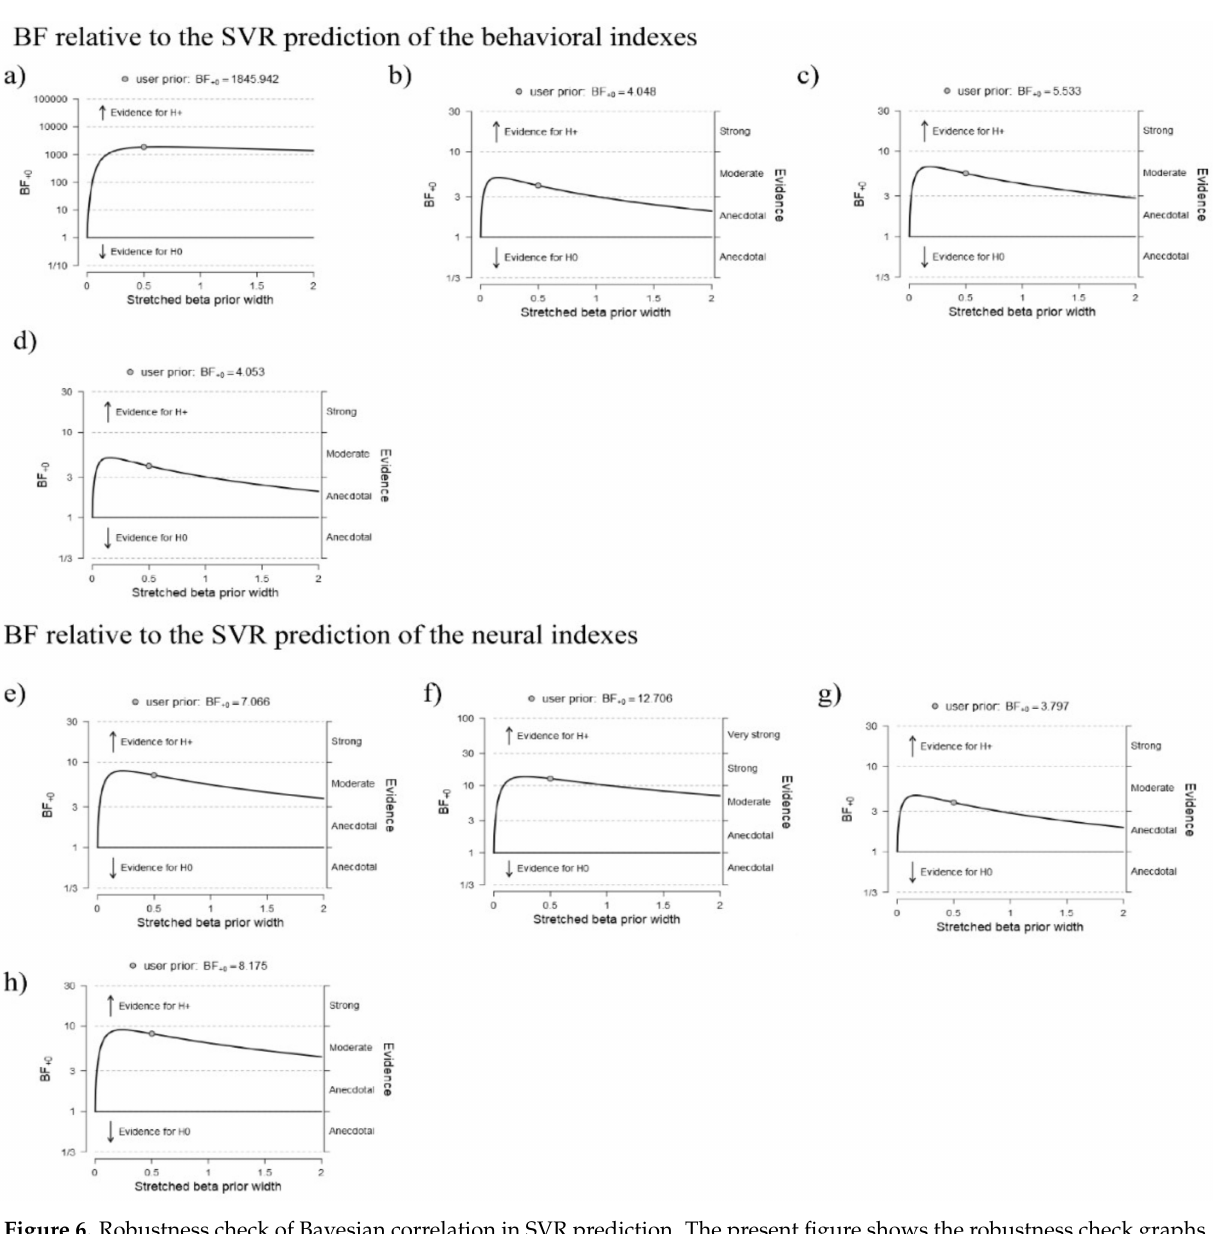
Figure 6. Robustness check of Bayesian correlation in SVR prediction. The present figure shows the robustness check graphs of the Bayes Factor reported in the main text. Each panel shows a robustness check for the respective correlation reported in manuscript. The graph highlights the variation of the Bayes Factor (BF) in dependence of the beta prior width providing a check of the reliability of the result. The evidence is classified based on the BF magnitude. Here we report the BF10 showing the probability of the alternative hypothesis (1) vs. the probability of the null hypothesis (0). Namely, the higher the BF, the higher the probability of the alternative hypothesis. ( a ) robustness check of the connectivity in the response implementation network predicting the behavioral delta global accuracy in the theta band, and the behavioral delta global RT and the delta global inverse efficiency score (IES) in the alpha band respectively in ( b , c ). In ( d ) the robustness check of the BF of the connectivity patterns within the expectancy-implementation network in the theta band predicting the delta global accuracy. In ( e ) the robustness check of the BF of the connectivity within the response implementation network predicting the P3 amplitude modulation (response implementation ERP effect) in the theta band. ( f ) robustness check of expectancy violation network predicting the omission-detection potential (ODP) (the expectancy-violation ERP effect) in the alpha, beta ( g ) and delta ( h ) frequency